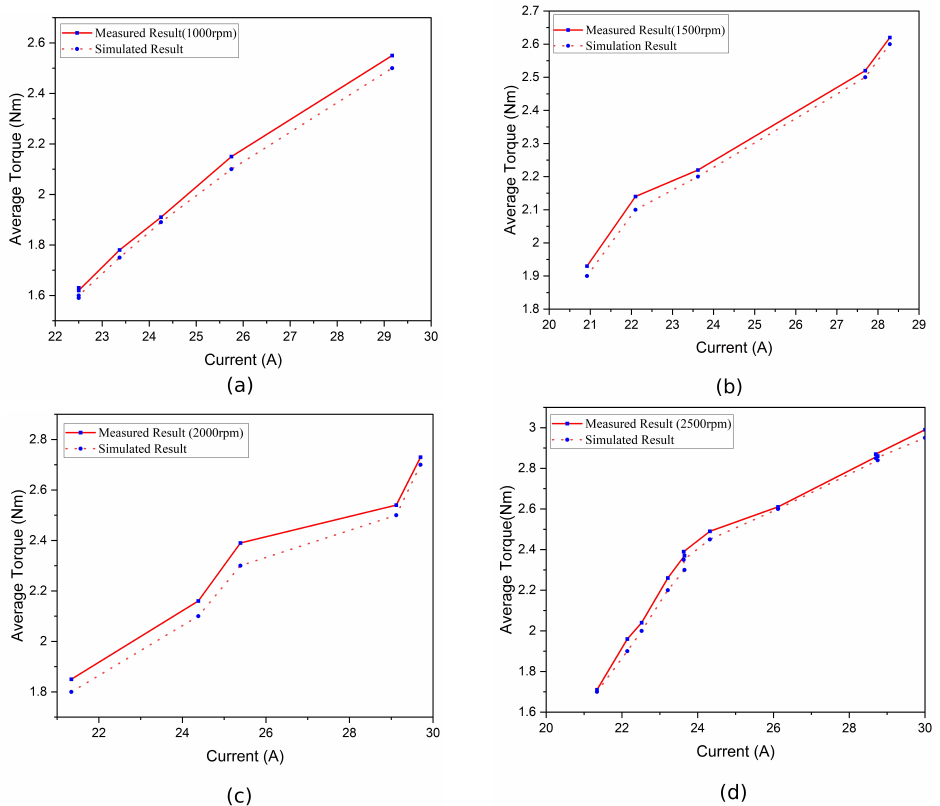
Figure 16. Average torque performance for variable speed of proposed HESRM: ( a ) 1000, ( b ) 1500, ( c ) 2000, and ( d )